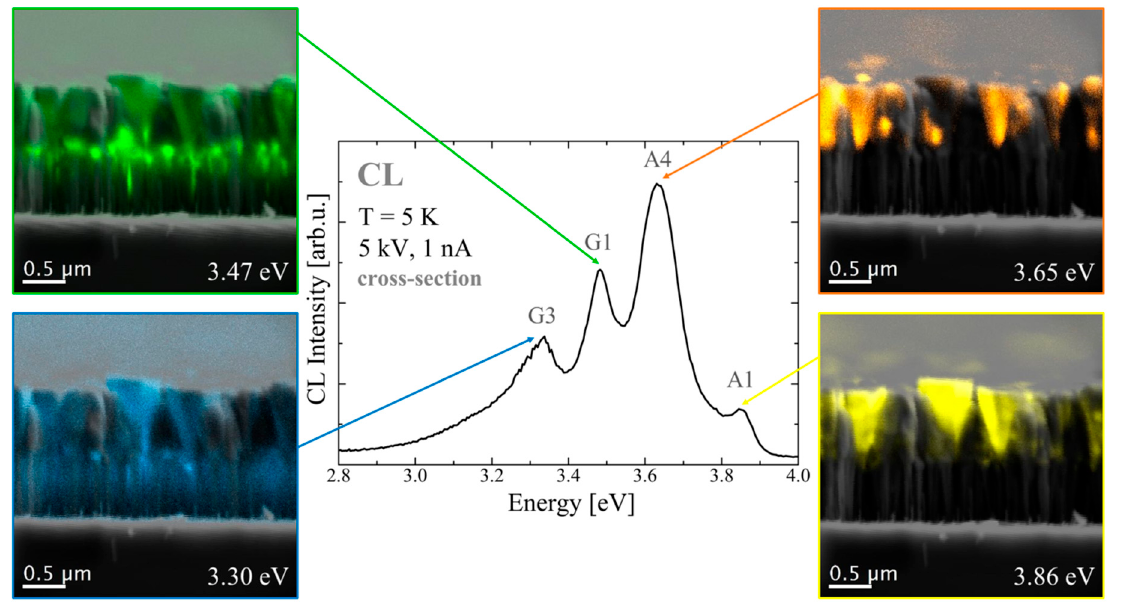
Figure 6. Cathodoluminescence spectrum of the NW array (central panel) and corresponding monochromatic CL maps superimposed with SEM images (sides), collected in the cross-sectional mode. Two bands—A1: 3.83 eV; and A4: 3.63 eV—are related to AlGaN luminescence. In the corresponding CL maps (right side), the emission is visible in the upper (p-type) part of the NWs. The third emission line, G1 centered at 3.47 eV, is related to the luminescence of the QWs, which proves the corresponding CL map (left side). The fourth one, G3 at 3.3 eV, most probably comes from the recombination of donor–acceptor pairs.